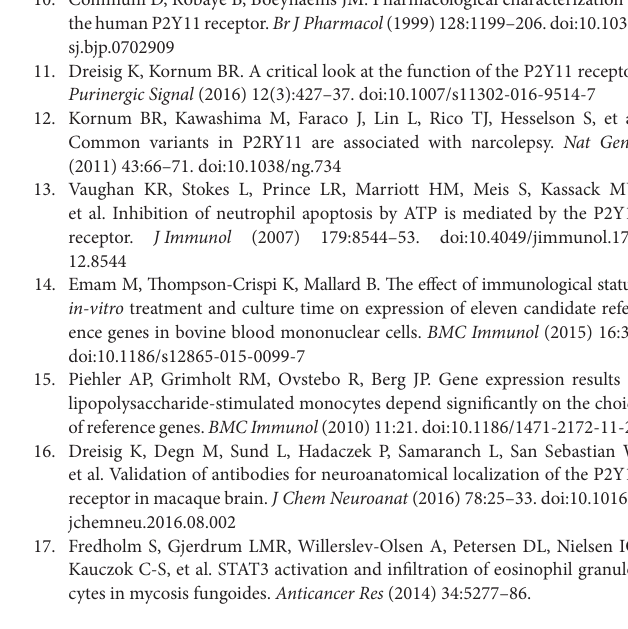
FigUre s1 | (a) Normalized calcium (left axis) and cyclic adenosine monophosphate (cAMP) (right axis) responses in GripTite cells expressing P2RY11 (filled square) and P2RY11 -mCherry (half-open square), respectively, when stimulated with BzATP. Part of data was previously published (Degn et al., 2017, Brain) and is shown as mean ± SEM, n = 1–2. (b) Relative fold change in P2RY11 (green) and P2RX7 (red) gene expression from human embryonic kidney-293 (HEK-293) and GripTite cells transfected with vectors encoding the two purinergic receptors. Data are shown as mean ± range, n = 2–3. Relative fold changes were calculated using the ΔΔ Ct approach and genes for β -actin and GAPDH as housekeeping genes. Control represents eGFP + empty vector and empty vector-transfected HEK-293 and GripTite cells, respectively. FigUre s2 | (a) Percentage of lactate dehydrogenase (LDH) activity in medium from CD4 + (orange rhomb) and CD8 + (purple square) T lymphocytes after 24 h stimulation with various concentrations of BzATP. Data are shown as mean ± SEM, n = 8–9 from three independent donors relative to maximum induced cell death by 1% Triton X-100. (b) Percentage of LDH activity in supernatant from CD4 + (orange rhomb) and CD8 + (purple square) T lymphocytes following incubation with 1,000 µM BzATP and P2Y 11 antagonist, NF340. Data were normalized to maximum cell death induced by 1% Triton X-100 with control values labeled C. Data are shown as mean ± SEM from two independent donors. FigUre s3 | Gating strategy for P2Y 11 detection on CD8 + T lymphocytes by flow